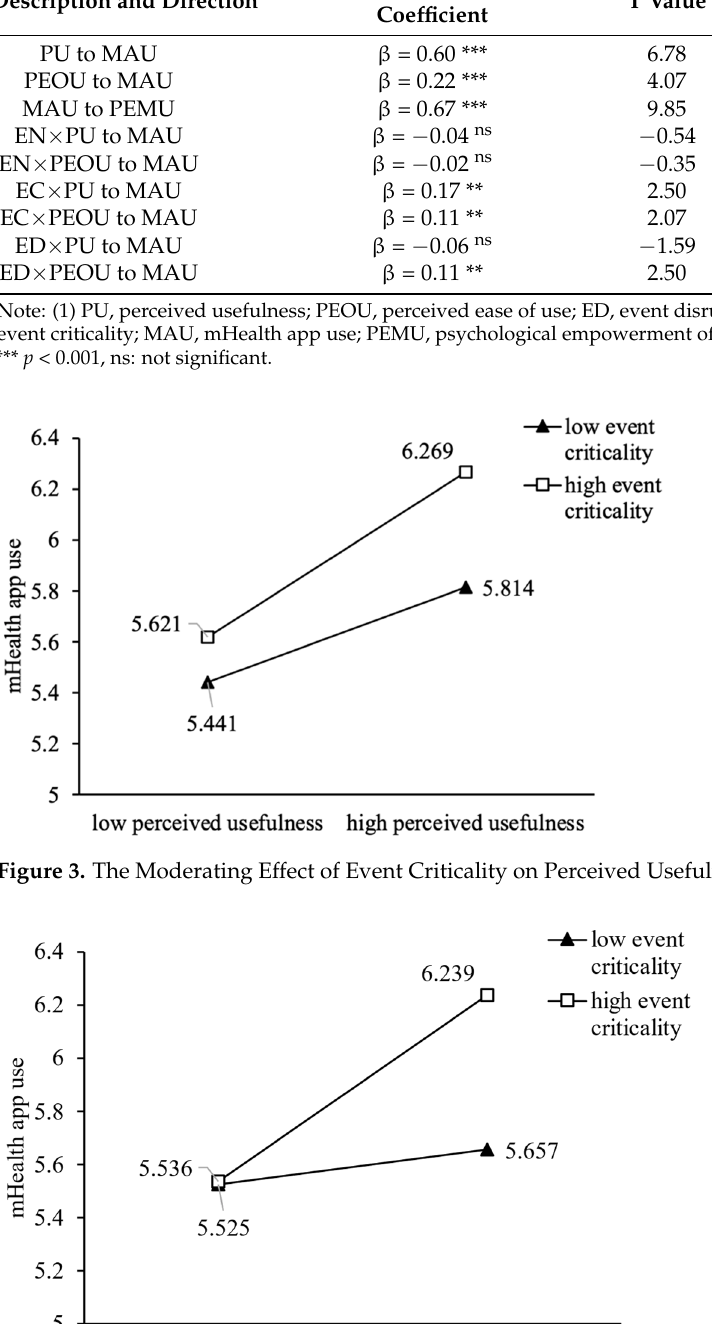
Figure 5. The Moderating Effect of Event Disruption on Perceived Ease of Use.